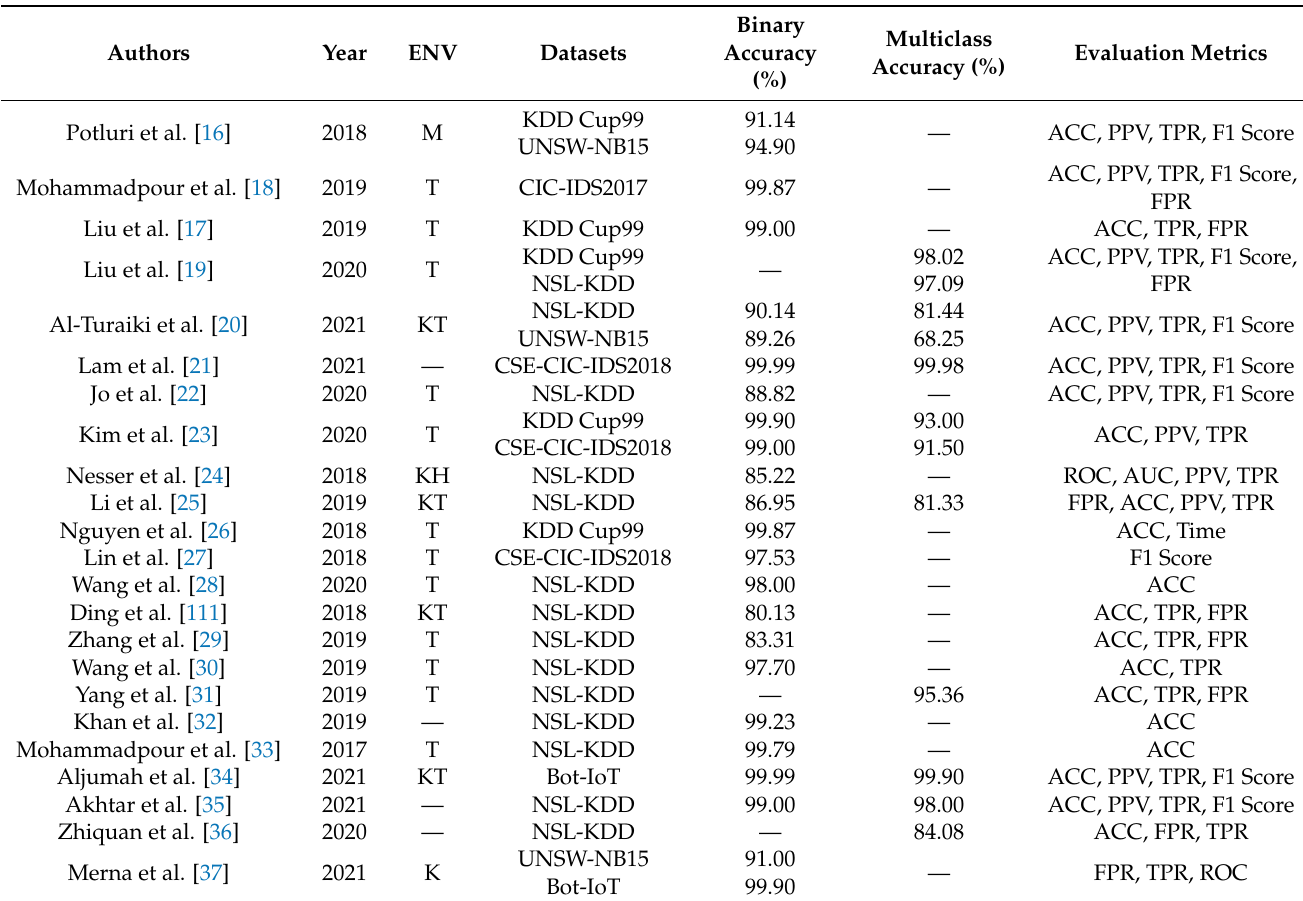
Table 5. Properties of group 1 (Single CNN-Based) IDS